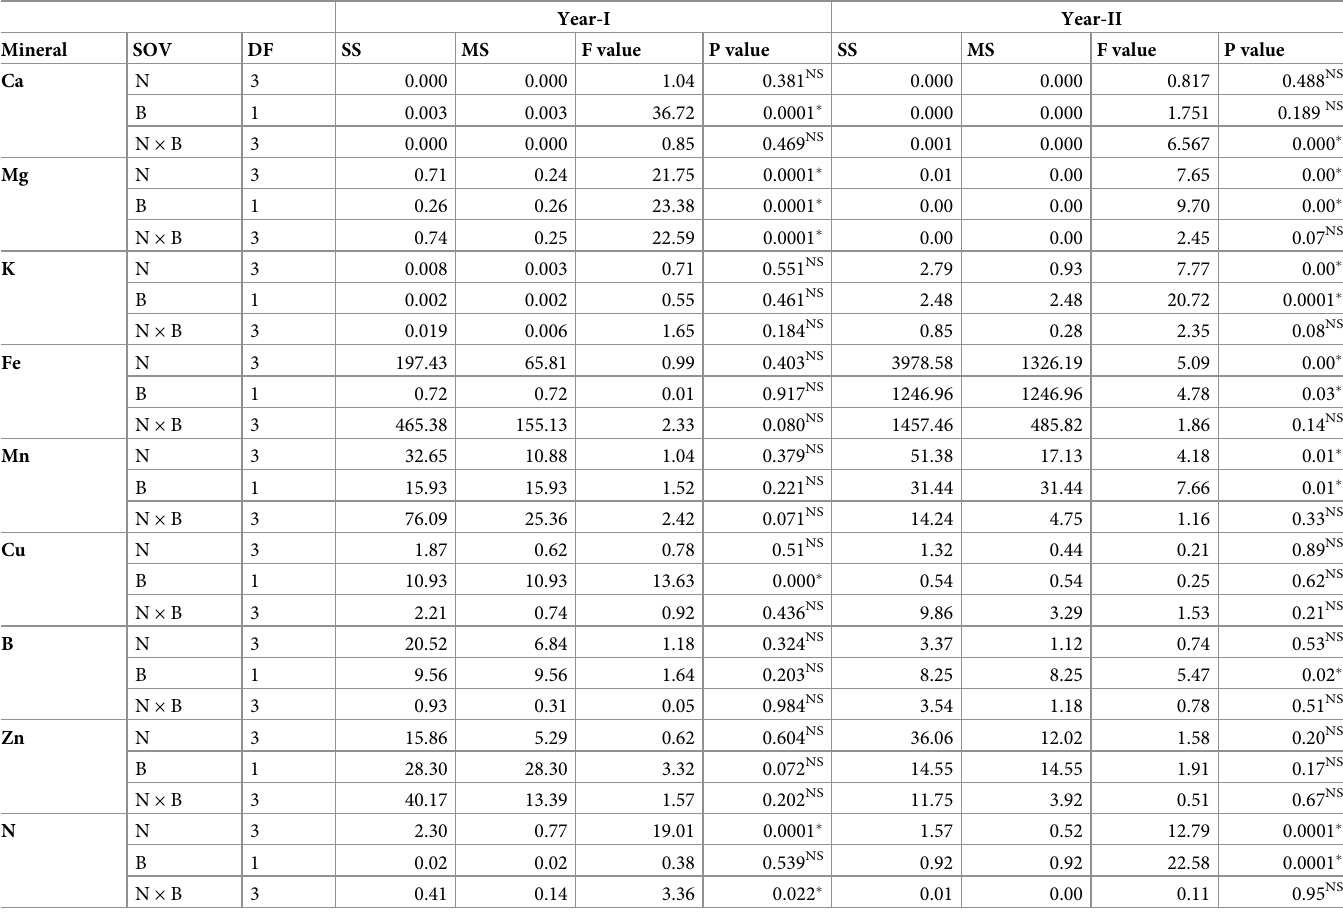
Table 3. Analysis of variance of different mineral uptake traits of grafted watermelon flesh grown under various nitrogen and boron doses.